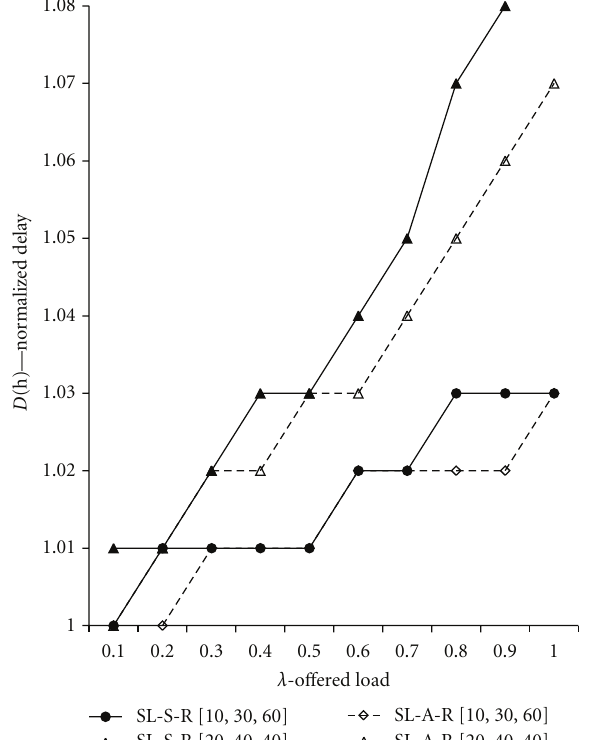
Figure 7: Normalized delay of medium priority packets versus o ff ered